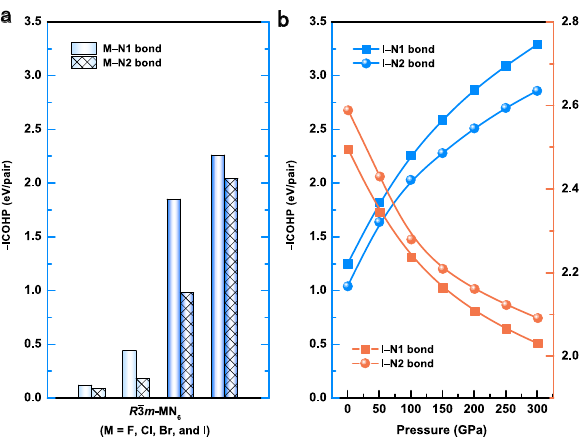
Fig. 5 Bonding analysis of halogen nitrides. a Negative integrated crystal orbital Hamilton population ( – ICOHP) of the M – N pairs in R (cid:1) 3 m -MN 6 (M = F, Cl, Br, and I) compounds at 100 GPa. The optimized atomic geometries are shown in the insets. b Pressure-induced variations in – ICOHP and bond lengths for the two types of I – N bonds in R (cid:1) 3 m -IN positive – ICOHP indicates the presence of bonding states. Source data are provided as a Source Data fi